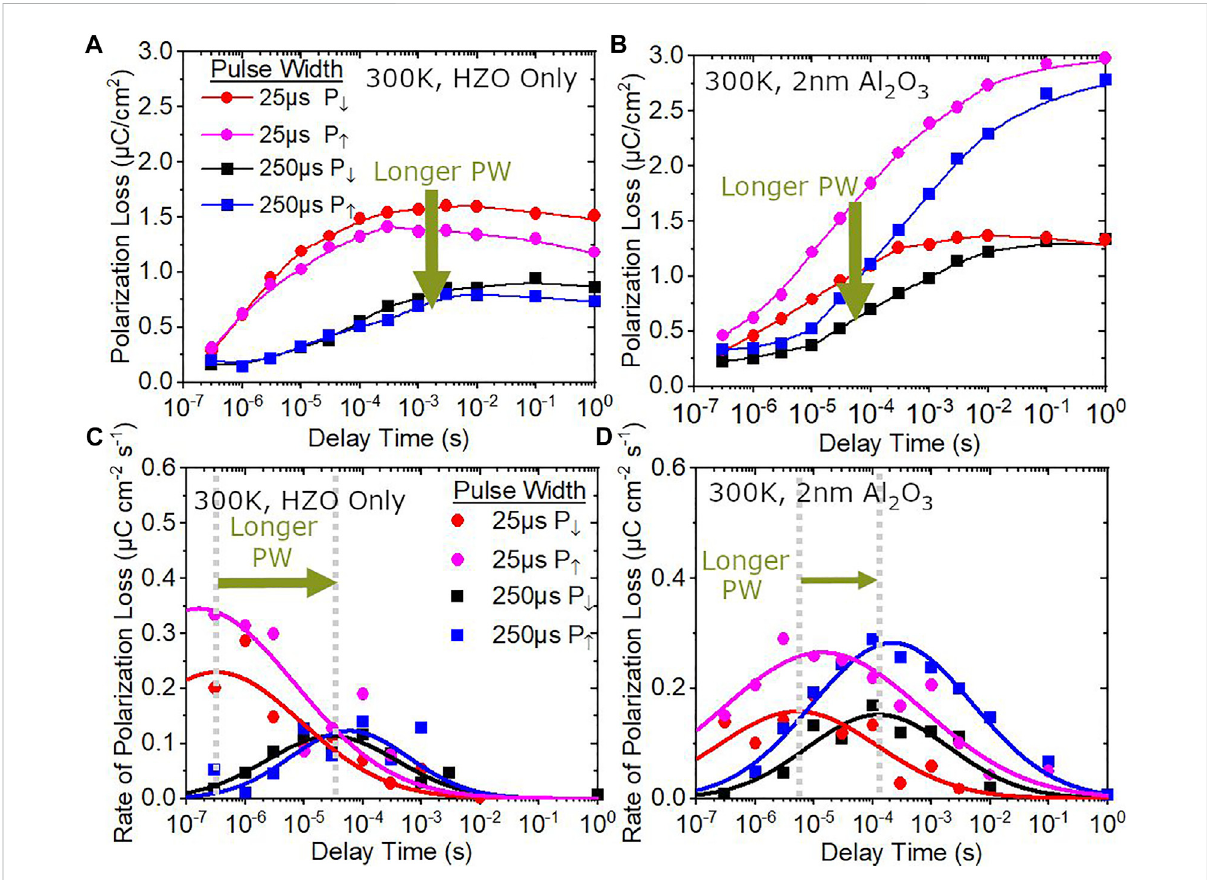
FIGURE 4 Polarization loss vs. delay time at 300 K for the (A) HZO only fi lm and (C) the HZO stack with a 2 nm Al 2 O 3 top interfacial layer. Rate of polarizationlossvs.delaytimeat300 Kforthe (B) HZOonly fi lmand (D) theHZOstackwitha2 nmAl 2 O 3 topinterfaciallayer.Thedatashowsupand down polarization states, as well as 25 and 250 μ s applied pulse